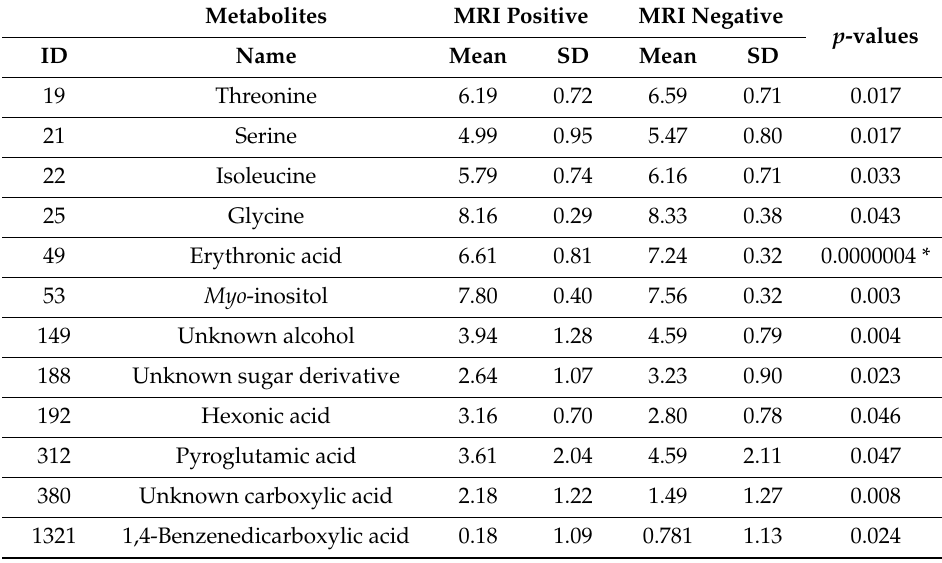
Table 3. Relative levels of the important metabolites within the two MRI findings groups. SD, standard deviation. Metabolites MRI Positive MRI Negative